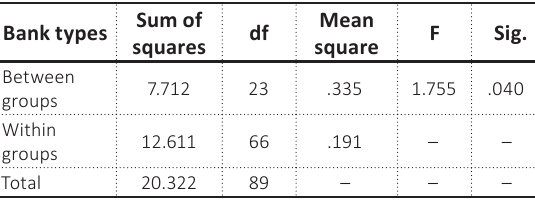
Table 7. ANOVA of differences between